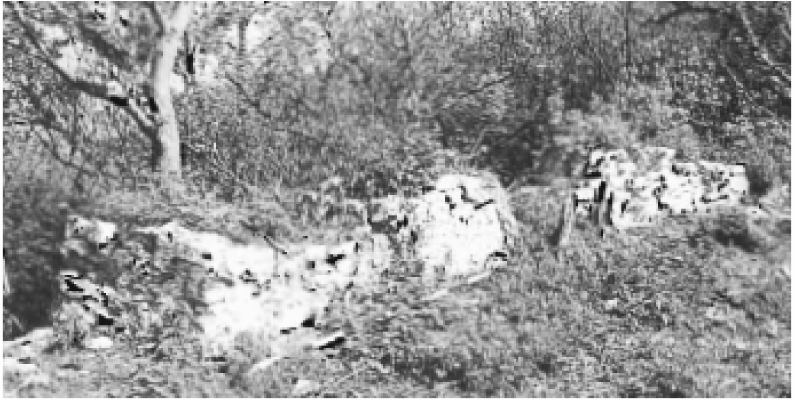
Figure 9. Remaining battlements at Miruji Dondae Fort. Reprinted with permission from Ref. [30]. 1999, Korea Army